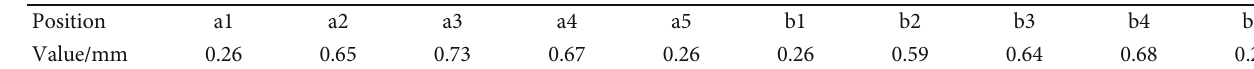
Figure 12: Positions to be measured. Table 2: Radii of the chamfers.